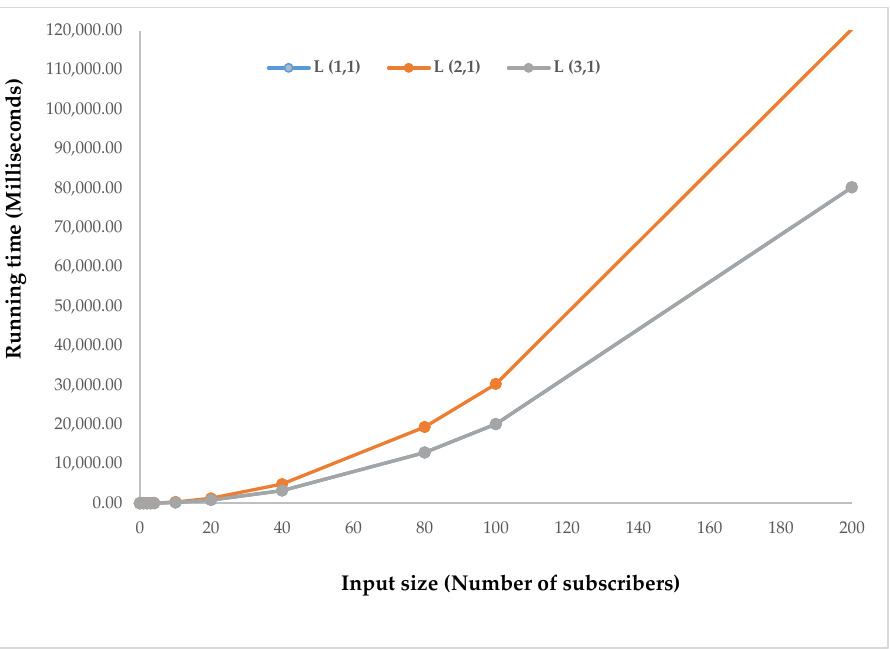
Figure 15. Comparison of the running times of the three algorithms for different input sizes.